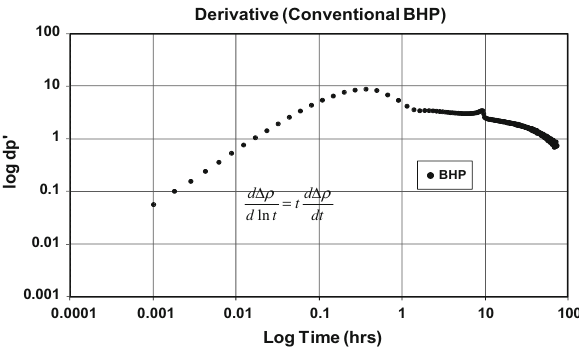
Fig. 12 Conventional BHP derivative versus time showing